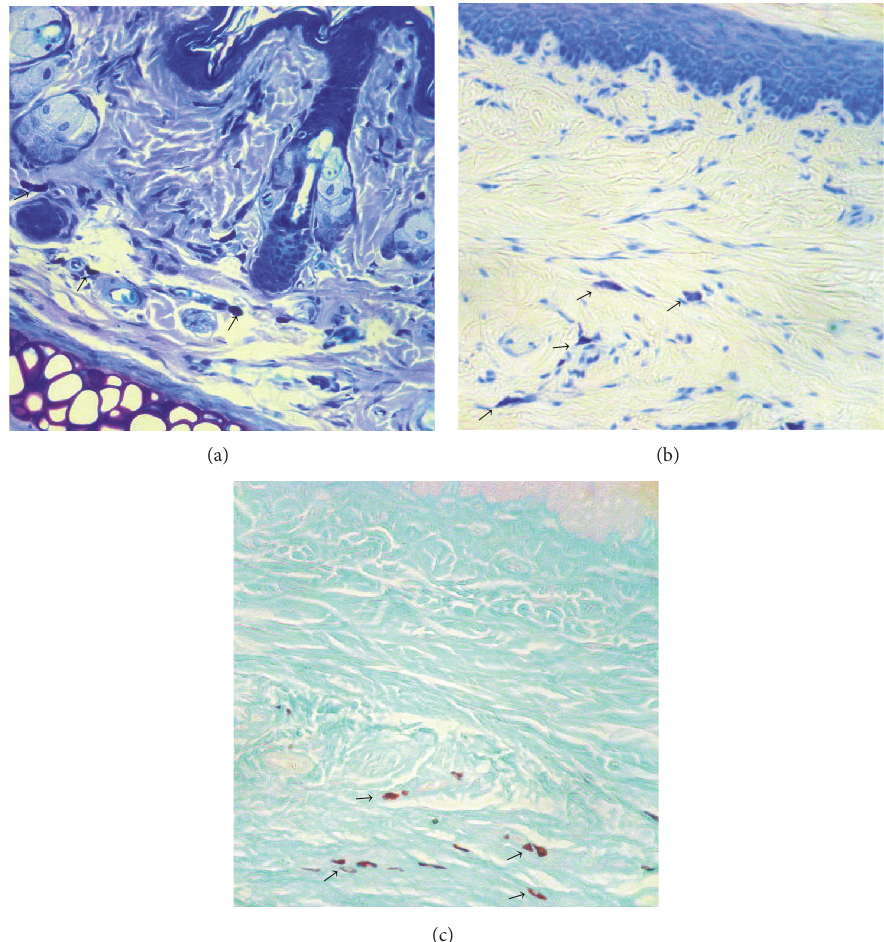
Figure 1: Histochemical aspect of mast cells ( → ) with (a) Giemsa staining; (b) acidified toluidine blue staining; (c) Alcian blue-Safranin O staining. Magnification